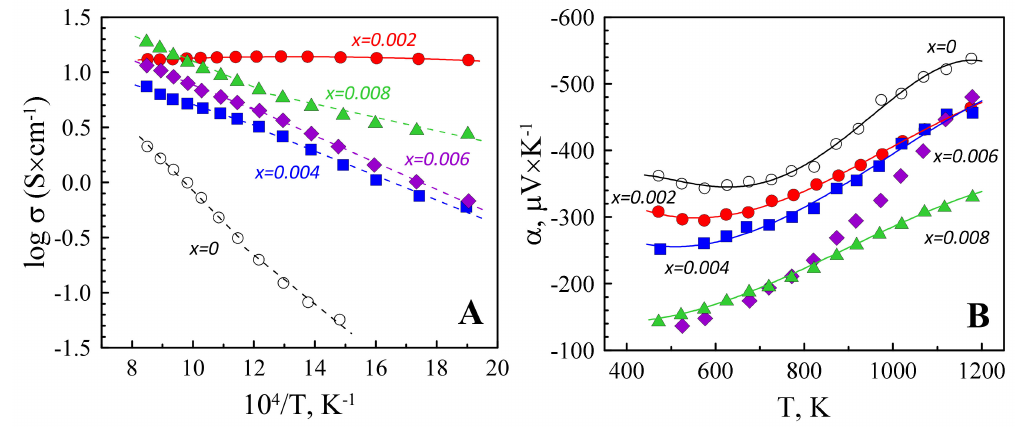
Figure 5. Temperature dependence of the electrical conductivity ( A ) and Seebeck coe ffi cient ( B ) of Zn 1 − x Ta x